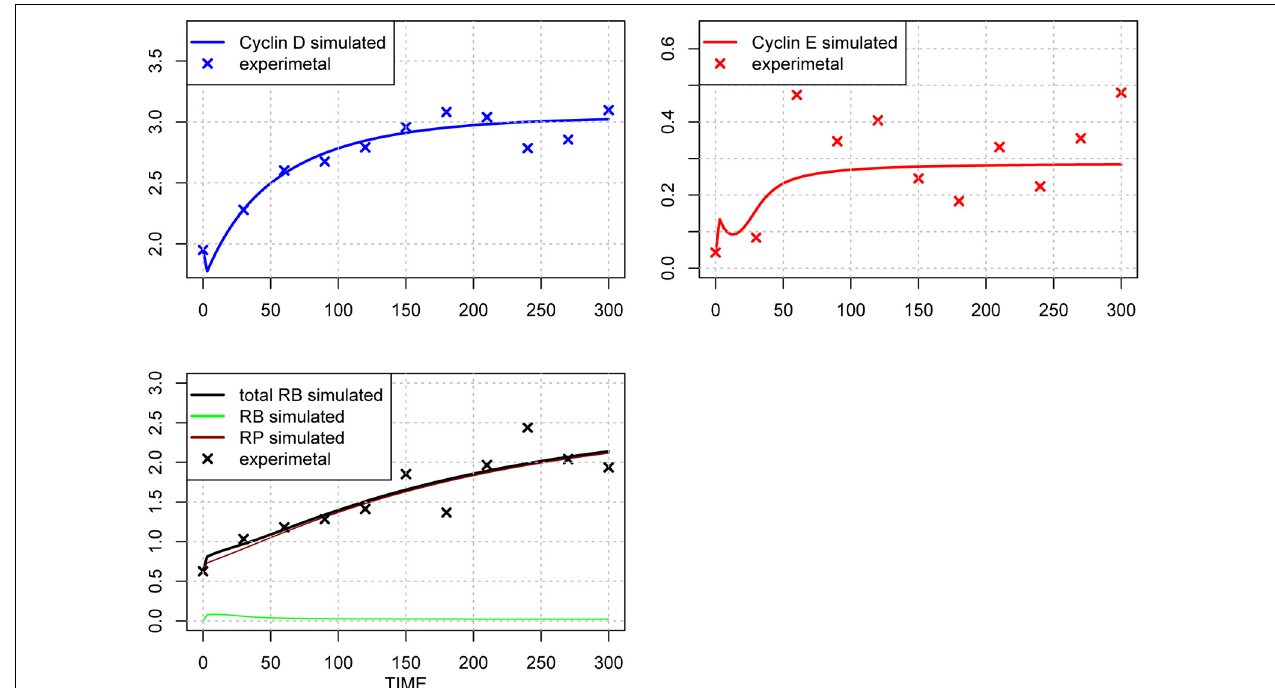
FIGURE 9 | Time-course of protein concentrations in the model. The fitting to the experimental data was performed for the 3 species. The x-axis indicates the Time [min], the y-axis indicates the concentration of the species [nM]. The upper left panel shows Cyclin D (line: simulation result, cross: experimental result), upper right panel shows Cyclin E (line: simulation result,